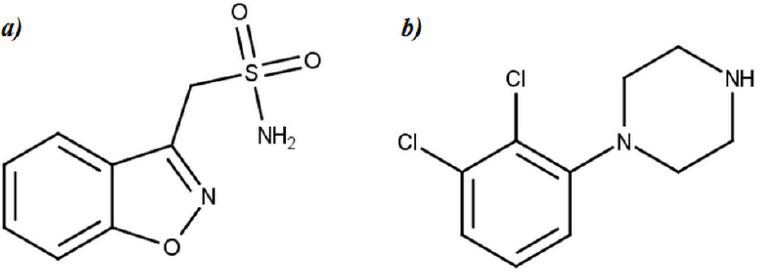
Figure 1. Chemical structure of ( a ) zonisamide and ( b ) internal standard (1-(2,3-dichlorphenyl)pi- perazine).